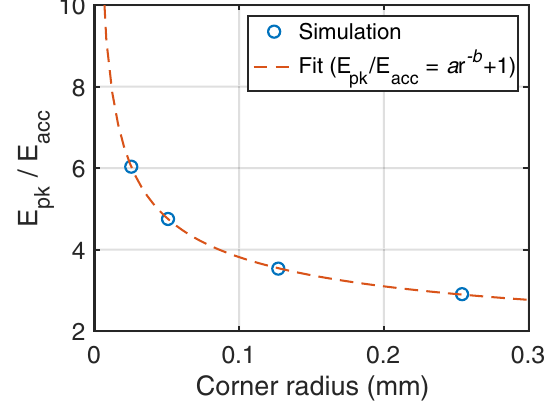
=E FIG. 9. E , the ratio of peak surface field to accelerating pk acc field, as a function of wagon wheel edge radius.